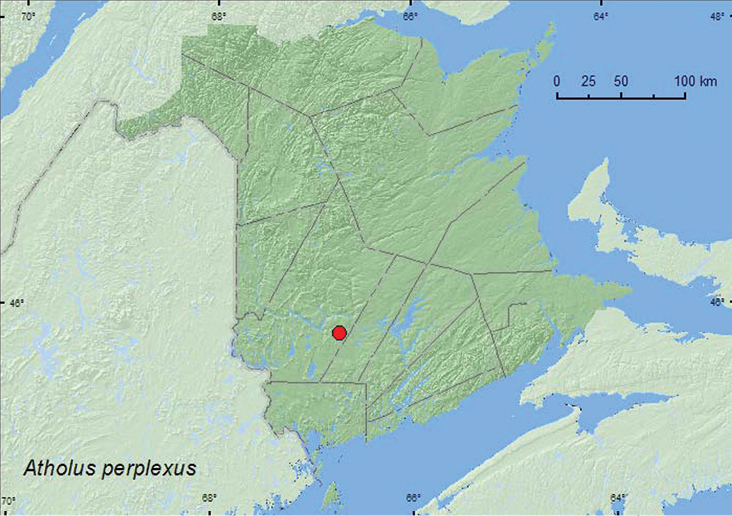
Collection localities in New Brunswick, Canada of Atholus perplexus.